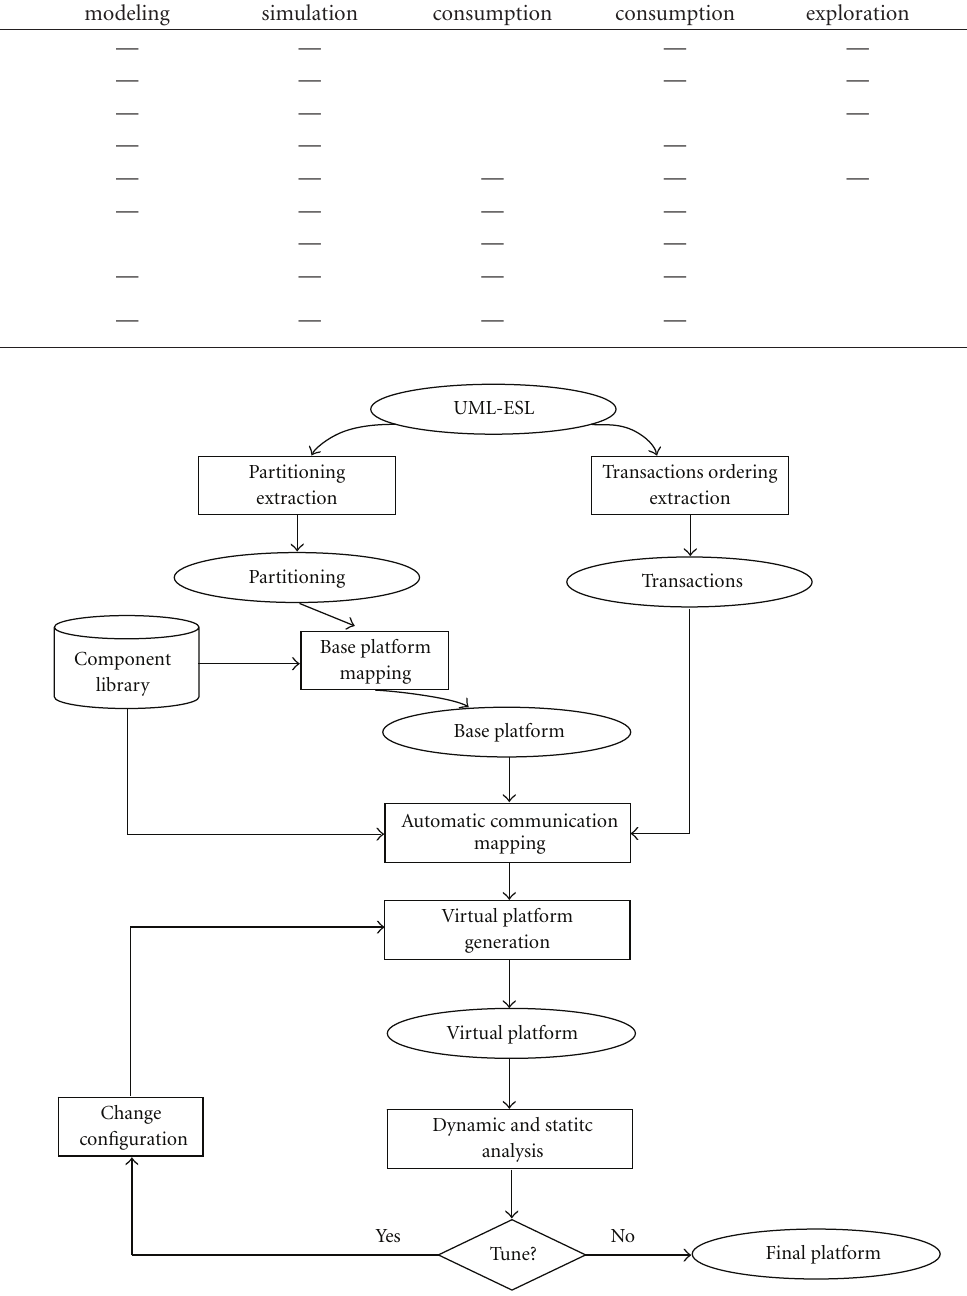
Figure 1: Proposed